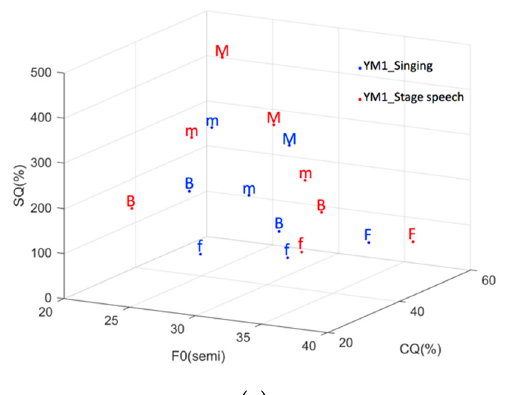
Figure 7. Three-dimensional diagrams of the clustering centroids: ( a ) the parameters of YM1, and ( b ) the parameters of YM2. m: modal; M: high adduction modal; B: breathy; f: untrained falsetto; F: high adduction falsetto.